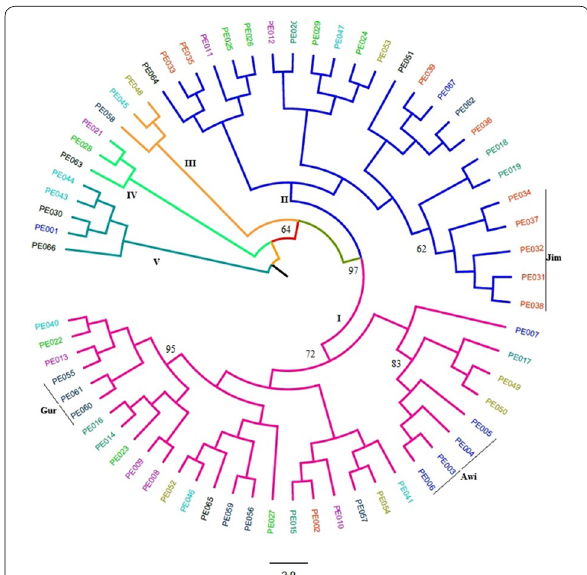
Fig. 3 UPGMA based cluster analysis of the 66 P. edulis accessions where, PE represents Plectranthus edulis and along with numbers ranging from 001–067 stands for the individual accessions. Corresponding populations are shown in Table 1. Numbers at the roots of the branches are bootstrap values, and bootstrap values of less than 60% were not shown